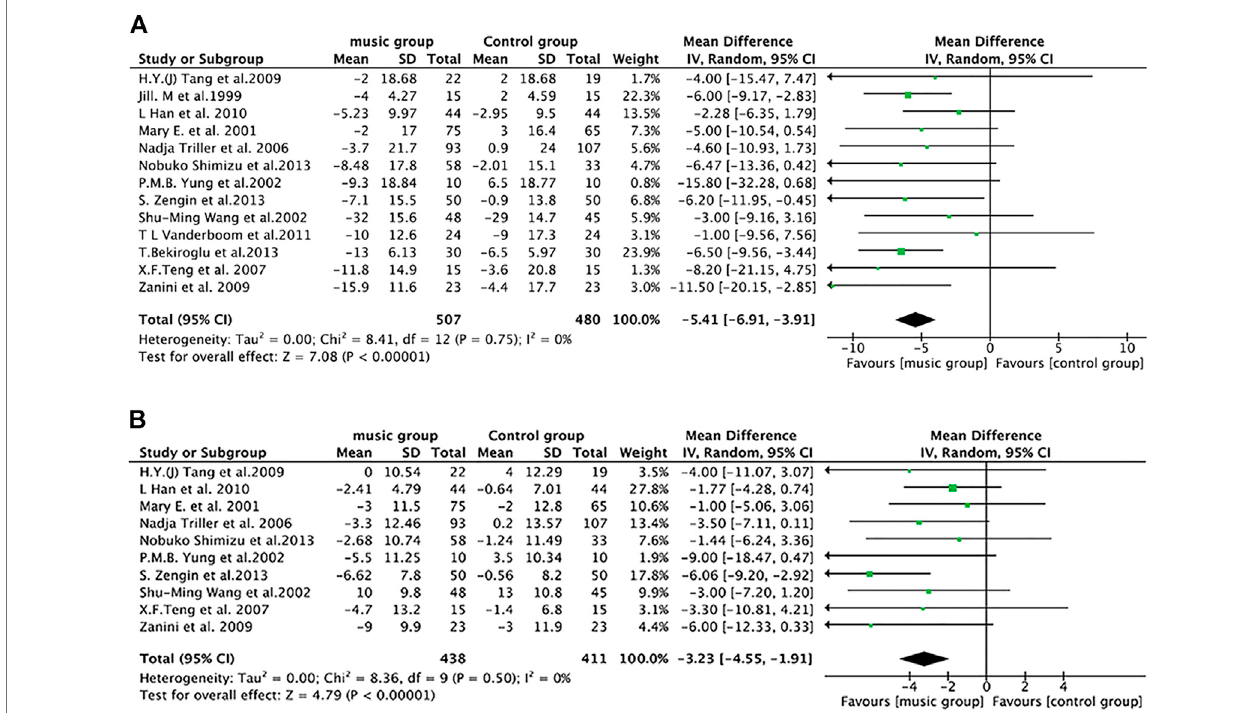
FIGURE 1 | Meta-analysis of music therapy on blood pressure (BP). (A) Systolic BP. (B) Diastolic BP. Odds ratios (95% CI) for music vs. control.